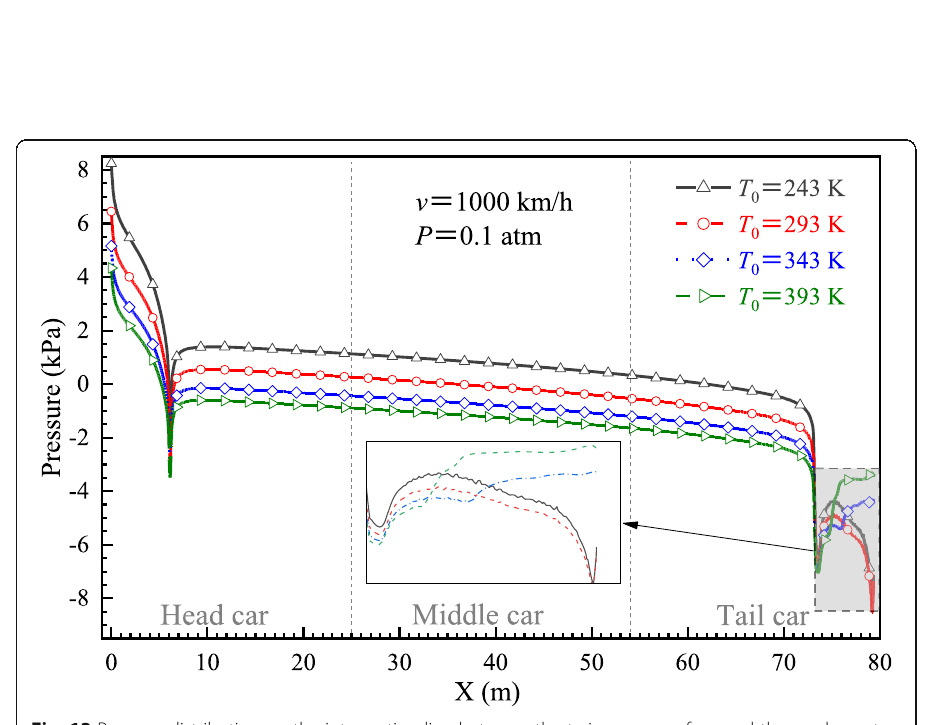
Fig. 13 Pressure distribution on the intersection line between the train upper surface and the xy plane at different T